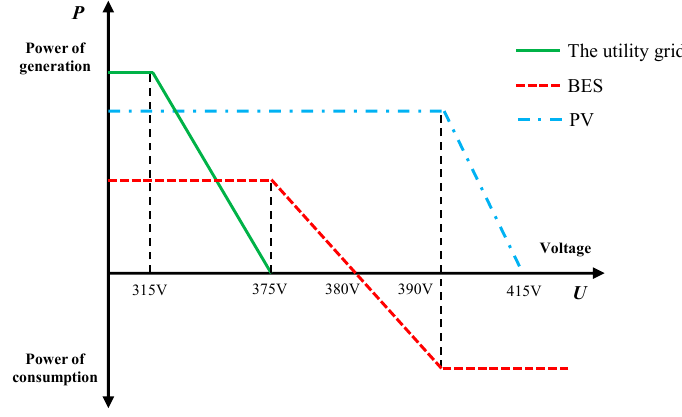
Figure 10. DC voltage droop control in LVDC building.